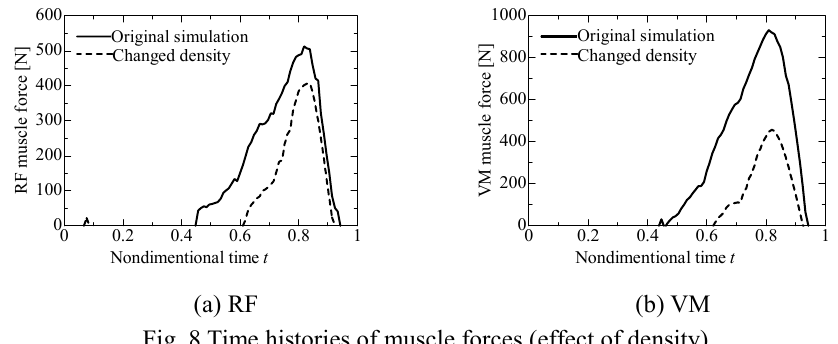
Fig. 8 Time histories of muscle forces (effect of density)